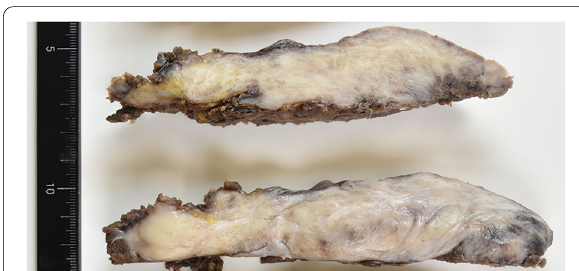
Fig. 3 Macroscopic findings of the tumor. The cut surface of the resected tumor exhibiting a heterogeneous, colored appearance, with a gray layer visible at the periphery of the